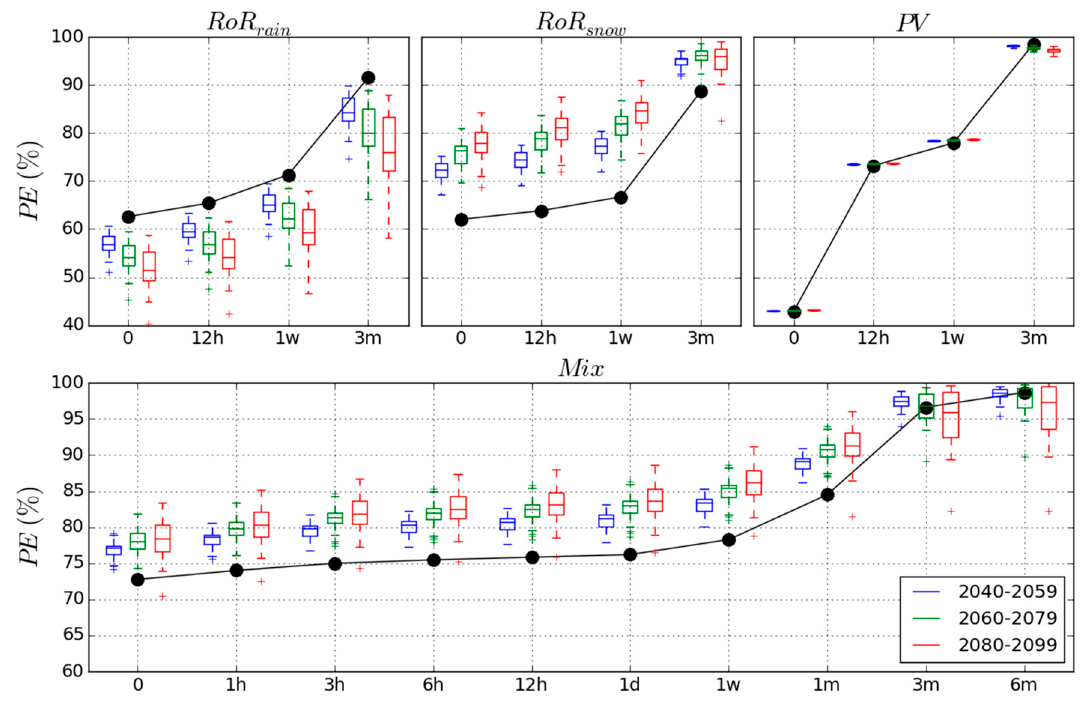
Figure 11. Evolution of the penetration rate as a function of GCM changes in precipitation and temperature variables for different storage capacities and for the given future periods. First row: from left to right, the penetration rates are given for RoR in low land area, RoR in alpine area, PV in the Veneto plains. Second row: penetration rate of the considered energy mix defined by S PV = 0.25 and S H = 0.75. Storage capacities are given in average load hours. Black dots show penetration rates obtained for the control period (same as Figure 5).